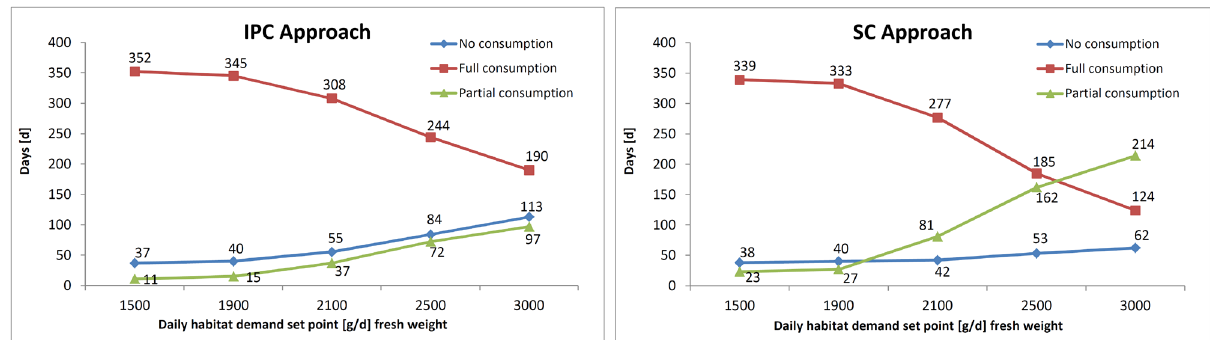
Figure 13: Overview of days with no-, partial-, and full habitat consumption for IPC (left) and SC (right). Both approaches indicate declining days of full consumption with increasing habitat demand set points and increasing days of no consumption. For days with partial consump- tion, the SC approach shows an increase in the number of days in comparison to the IPC approach. For the 2100 g/d case: IPC 37 days versus SC: 81